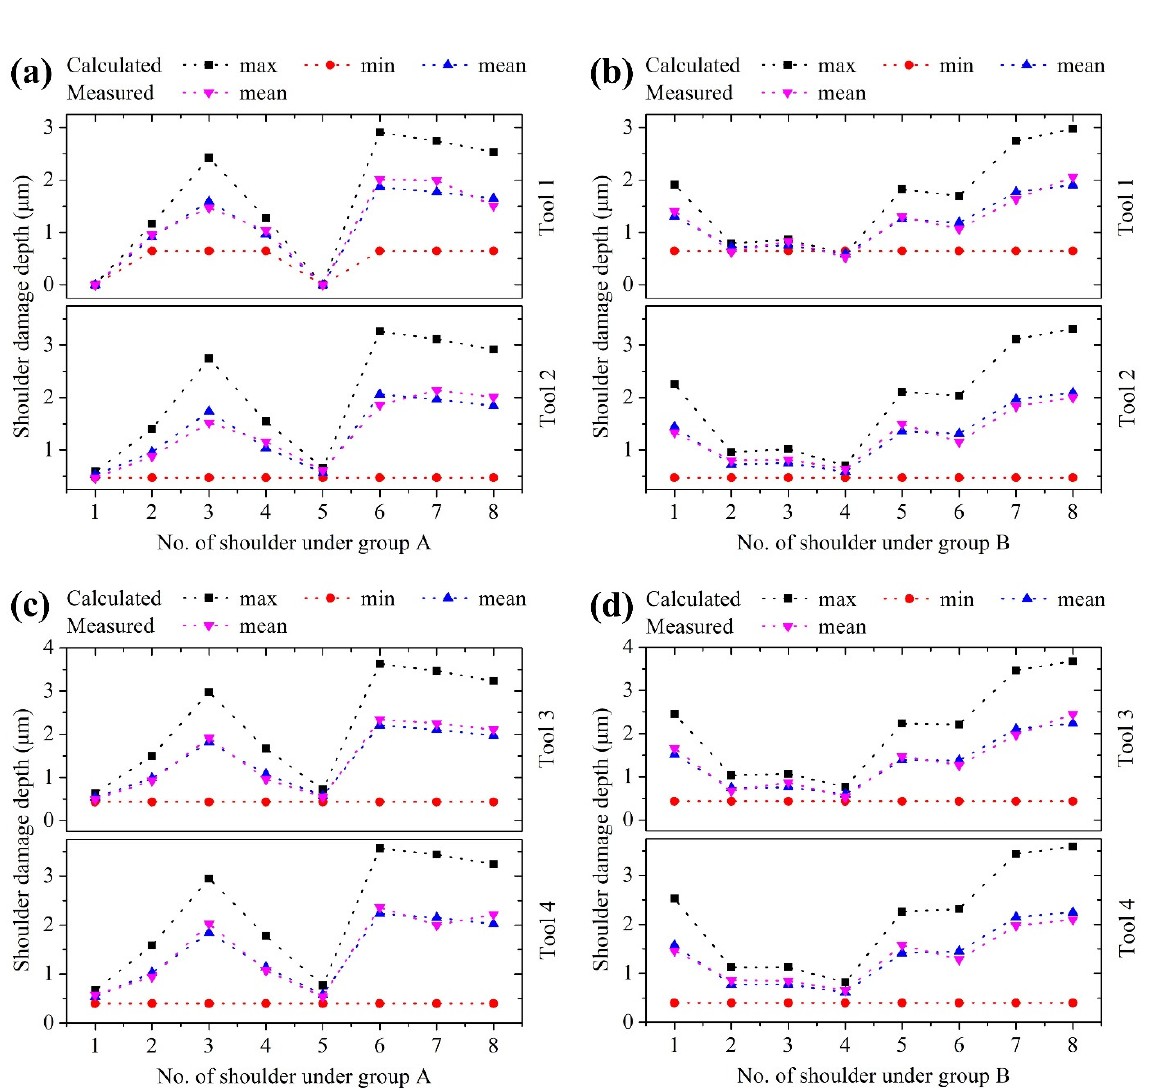
Figure 8. Measured and calculated shoulder damage depths under ( a ) group A and ( b ) group B using tools 1 and 2, and under ( c ) group A and ( d ) group B using tools 3 and 4.